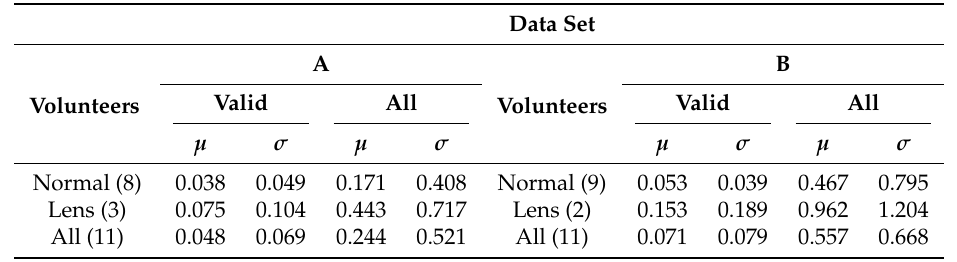
Figure 7. Mean RMS for each target from the calibration-like tests. ( a ) Surface plot; ( b ) Histogram. Table 3. Statistical results of the precision using the data samples of the calibration-like tests of eighteen points. The number of volunteers is indicated in parenthesis; floating-point values represent angular distances in